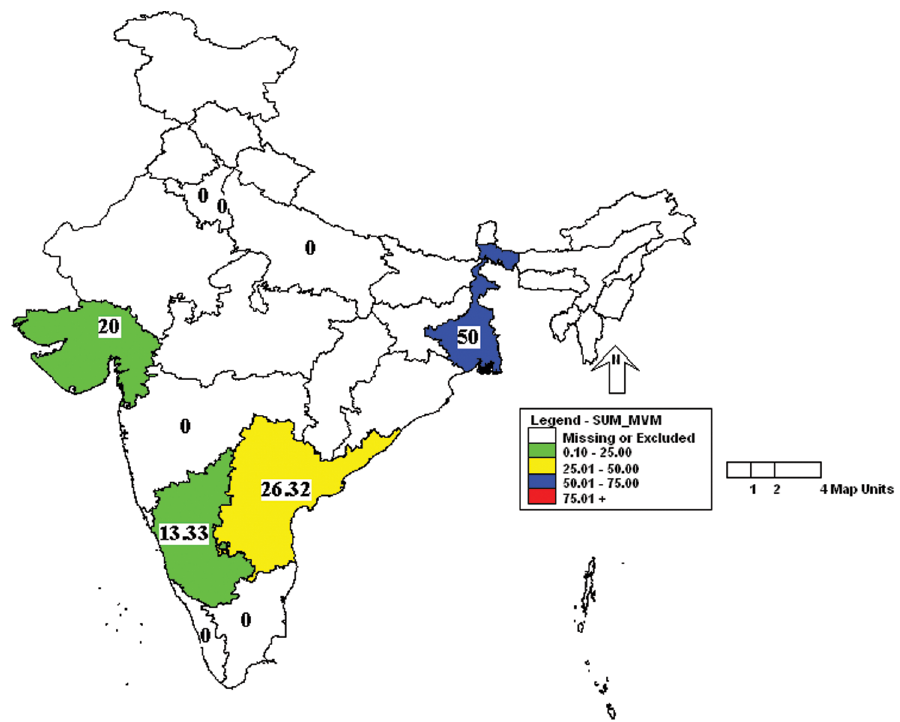
Fig 3. Incidence of minute virus of mice (MVM) in different states of India. Green — 00.00 to 25.00%; Yellow — 25.01 to 50.00%; Blue — 50.01 to 75.00%.